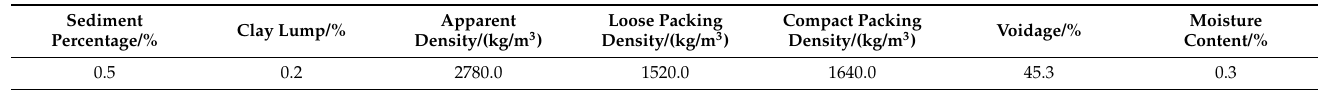
Table 6. Mix proportion of magnesium oxychloride cement reinforced concrete.